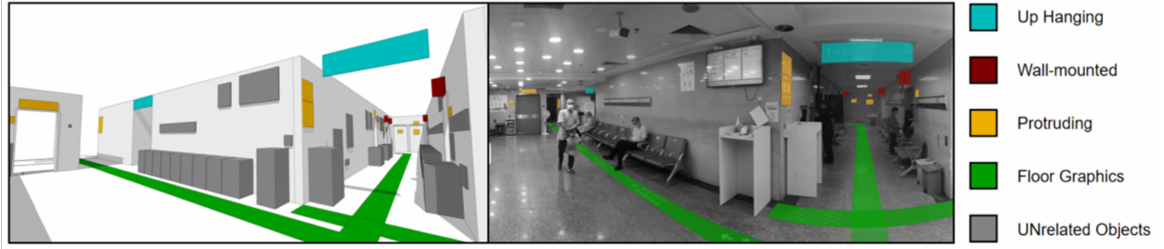
Figure 8. The 3D model of ED